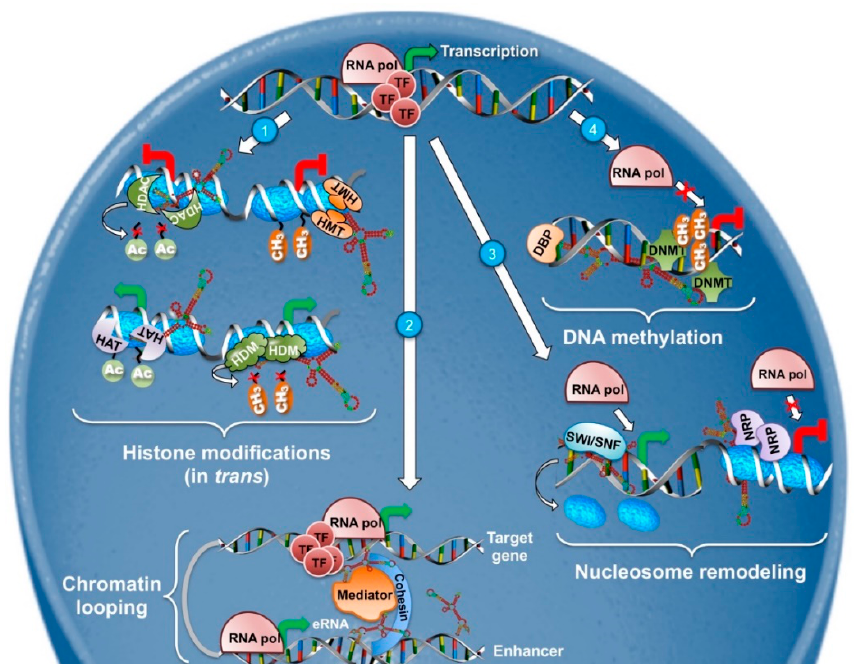
Figure 1. LncRNAs in epigenetic regulation of gene expression. Schematic models of (1) trans -acting lncRNAs recruiting histone deacetylases (HDACs, upper left), histone methyltransferases (HMTs, upper right) associated to gene repression, or histone acetylases (HATs, lower left) and histone demethylases (HDMs, lower right) associated to transcription-permissive chromatin; (2) enancher RNA (eRNA) recruiting the Mediator complex—with cohesin-based stabilizing contacts—responsible for DNA looping and distal transcriptional activation of target genes; (3) lncRNAs interacting with nucleosome destabilizing proteins, such as the SWI/SNF complex (left), causing nucleosome exclusion and gene activation, or with remodeling proteins (NRPs, right) associated with chromatin condensation and transcriptional repression; and (4) lncRNA acting as a scaffold for DNA methyltransferases (DNMTs) and DNA-binding proteins (DBP), and driving gene promoters’ methylation and their transcriptional repression.